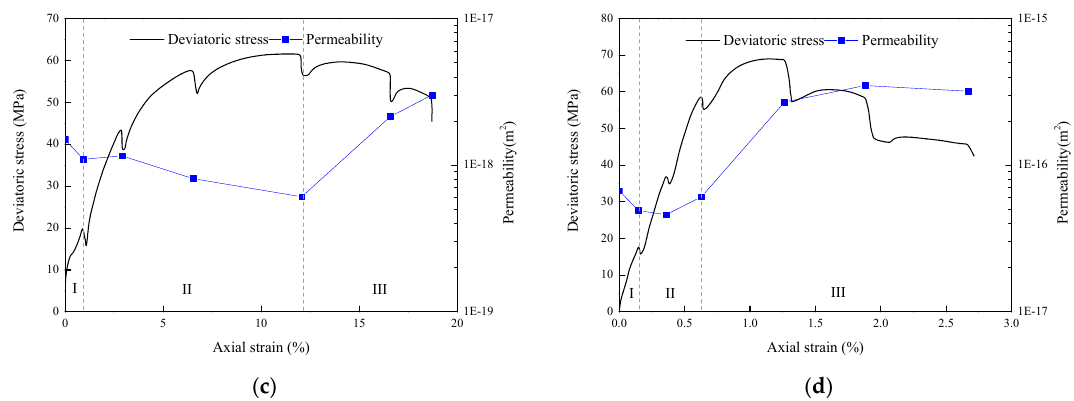
Figure 13. Stress and permeability versus axial strain. ( a ) ω = 3.00% (SR-1); ( b ) ω = 13.07% (SR-2); ( c) ω = 39.16% (SR-3); ( d) ω = 60.02% (SR-4).